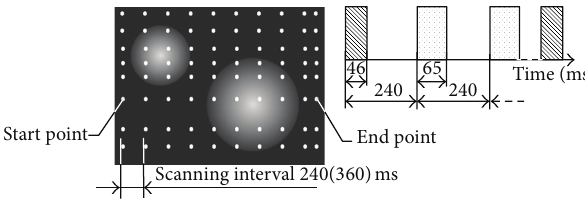
Figure 3: Auxiliary sound signals during the parallel scanning